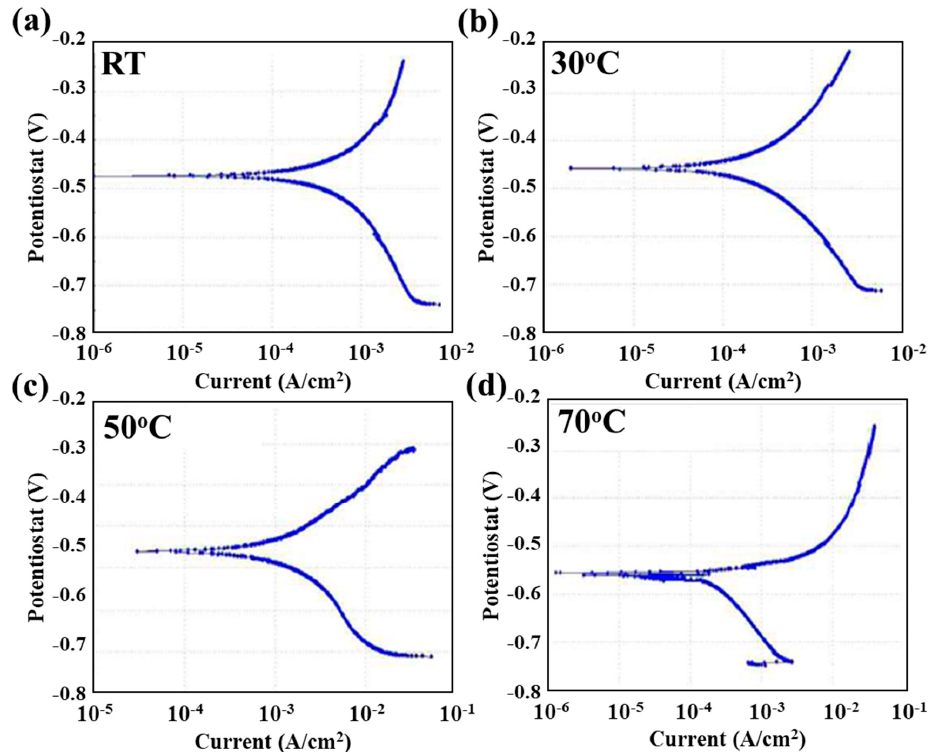
Figure 5. Potentiodynamic polarization curve of the weldment couple after PWHT at ( a ) RT, ( b ) 30 °C, ( c ) 50 °C and ( d ) 70